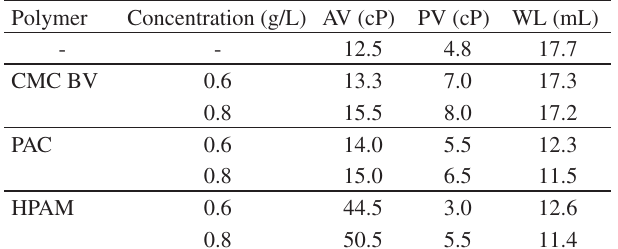
Table 1. Apparent and plastic viscosities and water loss of bentonite disper- sions before and after treatment with polymer, without added salt. Polymer